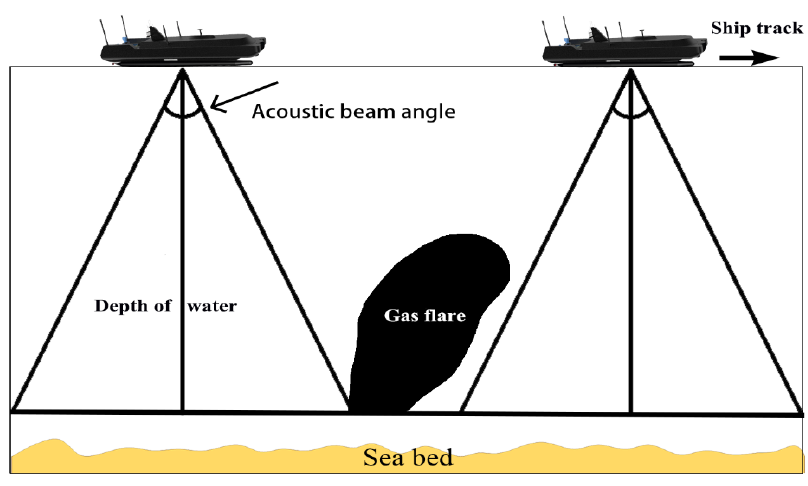
Figure 5. Acoustic bubble monitoring.